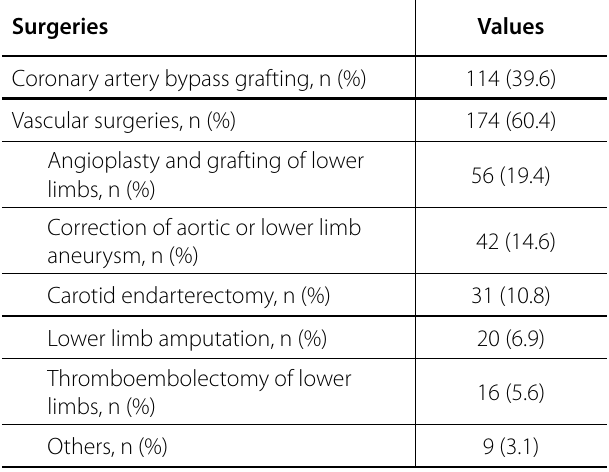
Table 2 . Surgical procedures performed (n=288).